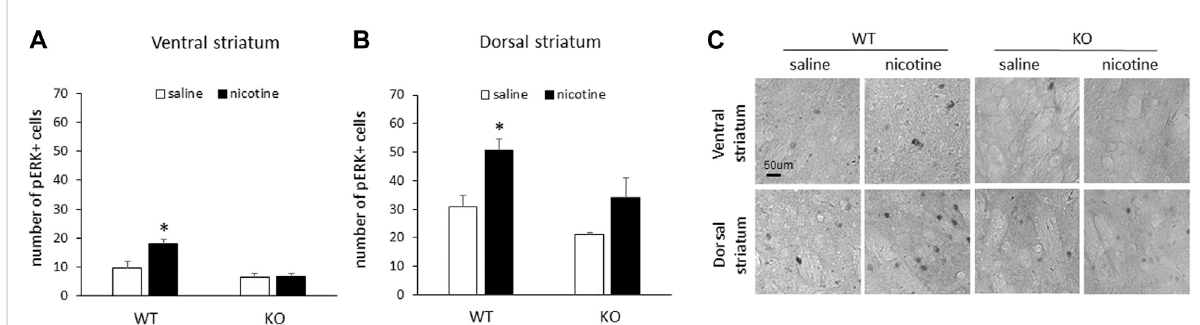
FIGURE 3 Repeated nicotine failed to increase striatal pERK in male RasGRF2 KO mice. (A) 10 days of nicotine (0.4 mg/kg IP) injections resulted in a signi fi cant increase in the number of pERK1/2-positive cells relative to saline controls in the ventral striatum of male RasGRF2 WT, but not KO mice ( n = 4 – 5/group). Data represent the mean number of pERK1/2-positive cells (±SEM) in each condition. (B) 10 days of nicotine (0.4 mg/kg IP) injections resulted in a signi fi cant increase in the number of pERK1/2-positive cells relative to saline controls in the dorsal striatum of male RasGRF2 WT, but not KO mice ( n = 4 – 5/group). Data represent the mean number of pERK1/2-positive cells (±SEM) in each condition. (C) Representative slices showing pERK-positive cells from the ventral and dorsal striatum of RasGRF2 WT and KO mice that received acute nicotine or saline injections. * p <